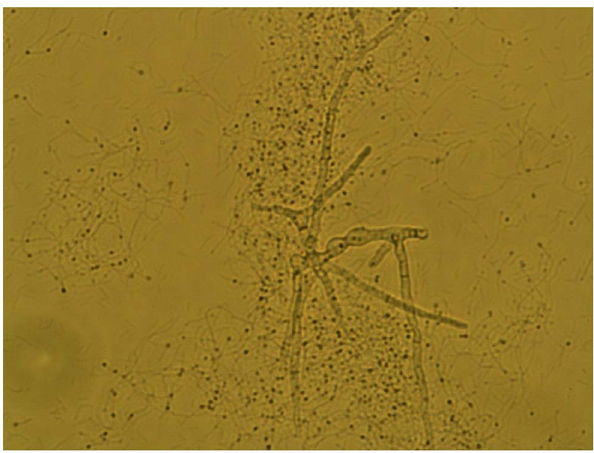
Figure 2. Bcell growth on A.niger mycelia. Microscopic images (2000 6 magnification) of Bcell culture growing on A. niger